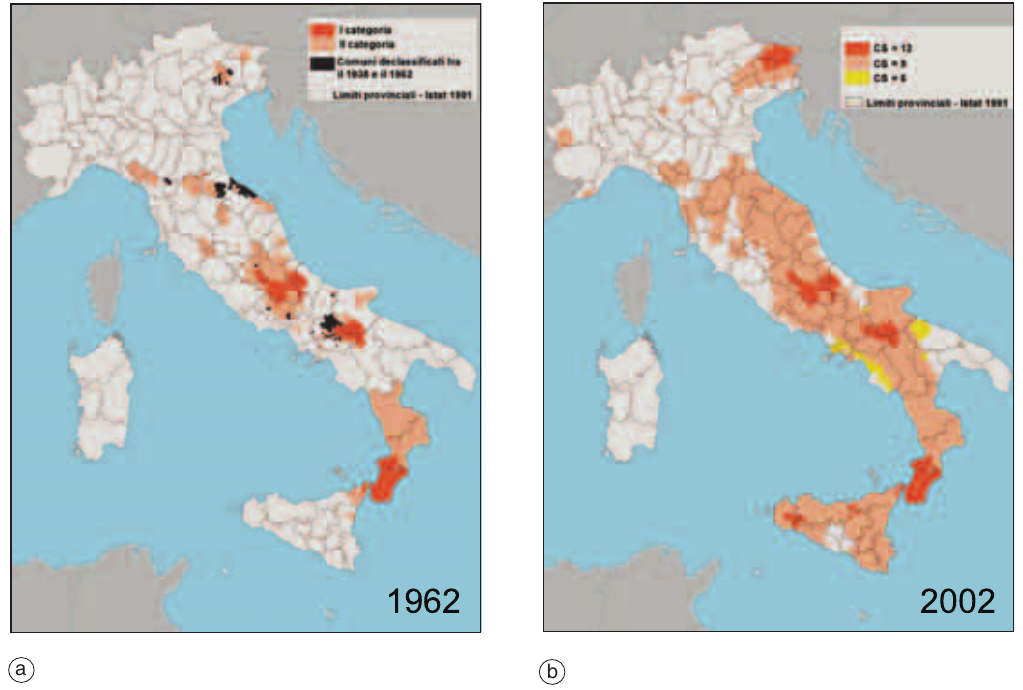
Fig. 1. Areas exposed to seismic risk in the Italian